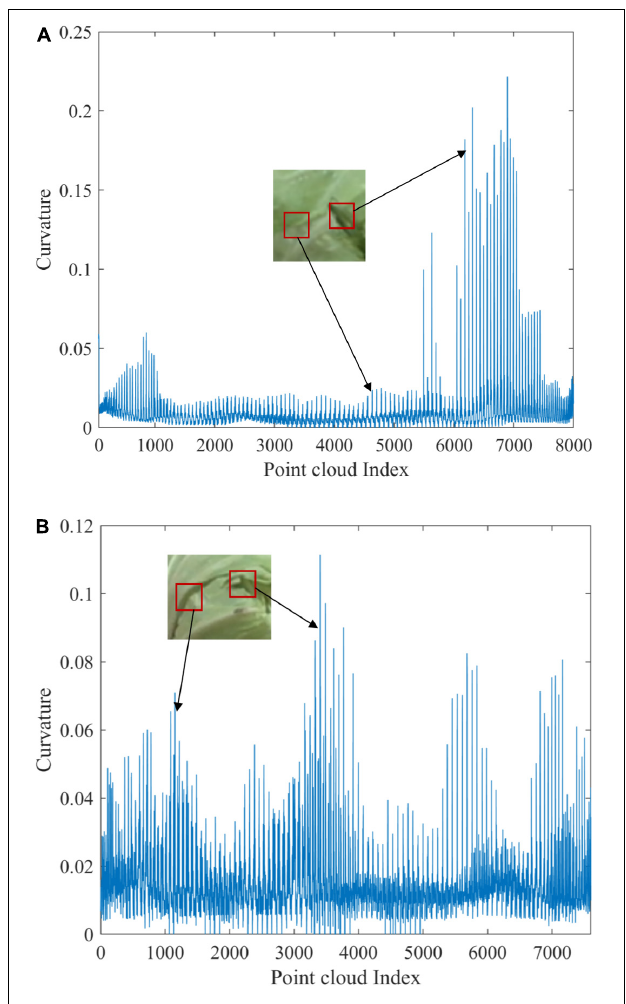
FIGURE 11 | Curvature curves of different variables of cabbage: (A) the curvature curve of the cracked sample of round-headed cabbage and (B) the curvature curve of the cracked sample of flat-headed